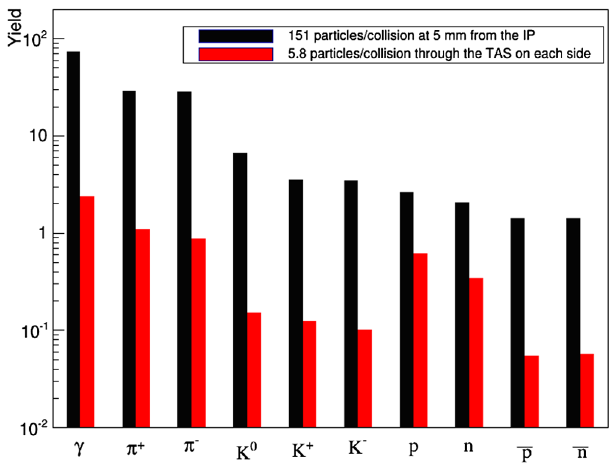
FIG. 1. Number of debris particles per single proton-proton inelastic interaction at 5 mm from the interaction point (black histogram) and at the exit of each 60-mm TAS aperture